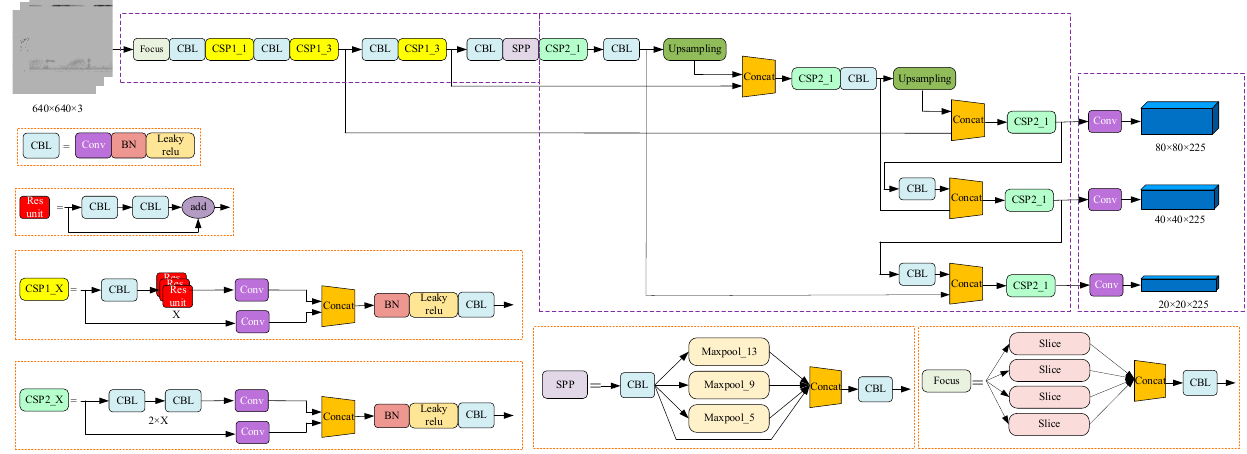
Figure 4. Flow chart of primary diagnosis based on deep forest. Table 1. Parameters of the YOLOv5 series network structure.